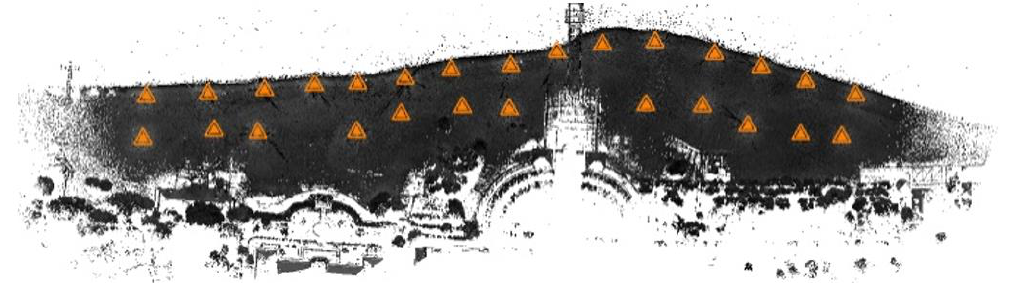
Figure 4. Terrestrial laser scanning (TLS)—the location of laser scanner measurement sites.